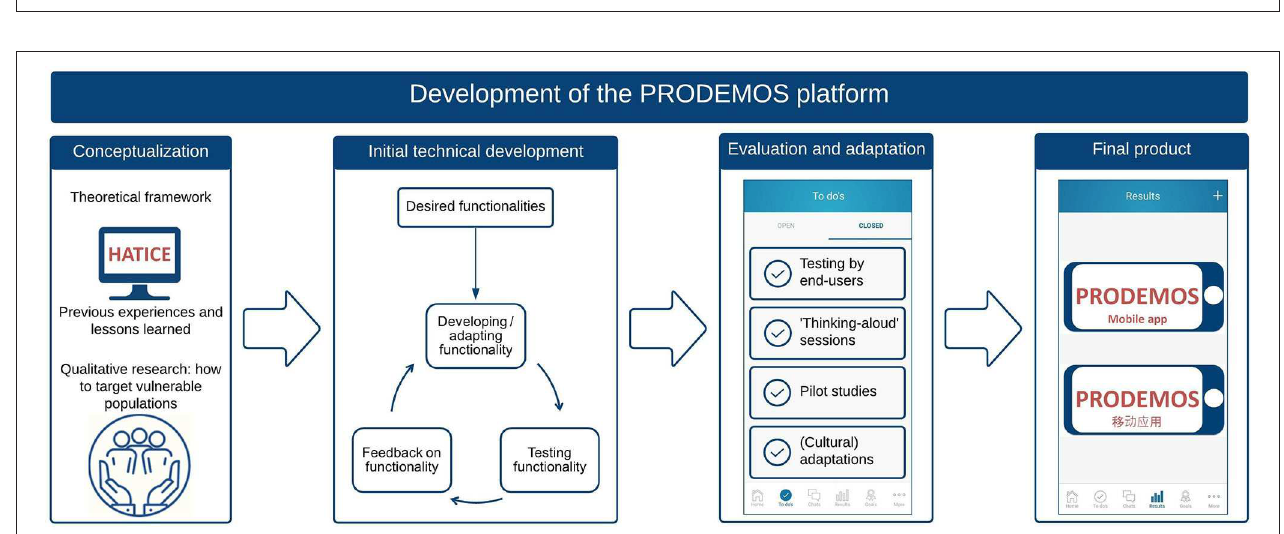
FIGURE 1 | Overview of the PRODEMOS platform and its interactions.